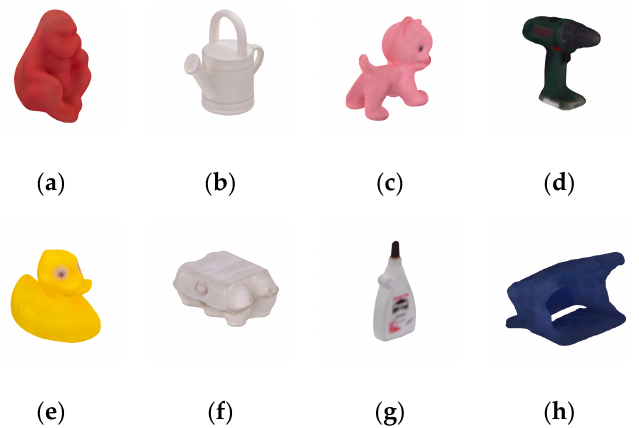
Figure 11. Eight objects in the Occlusion dataset: ( a ) Ape; ( b ) Can; ( c ) Cat; ( d ) Driller; ( e ) Duck; ( f ) Egg Box; ( g ) Glue; ( h ) Hole Punch.